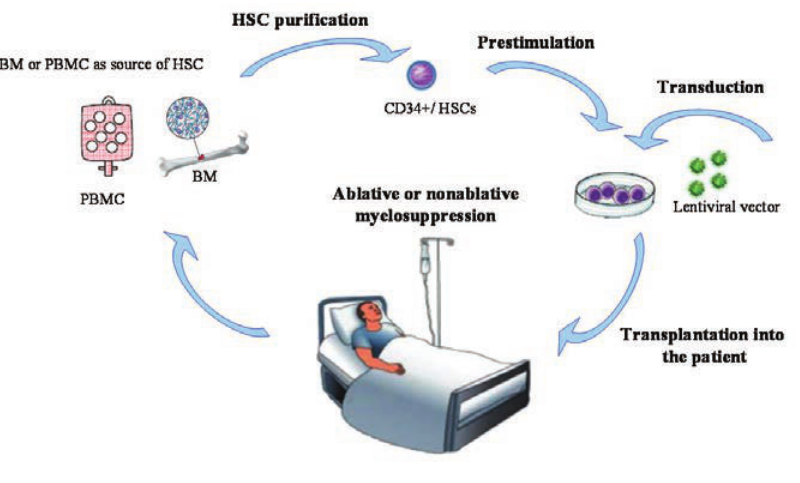
Figure 1. Schematic representation of hemopoietic stem cell (HSC)-based gene therapy for b- thalassemia. HSCs collected from bone marrow (BM) or from peripheral blood mononuclear cells (PBMC) after mobilization, are processed to purify CD34+ hematopoietic stem cells ( HSC purification ). The cells are cultured in early-acting cytokines ( prestimulation ) and transduced with a therapeutic globin lentiviral vectors designed to express high levels of normal human b -globin ( transduction ). The patient is treated with ablative or non-ablative myelosuppression, and then engrafted with the vec- tor-modified cells ( transplantation